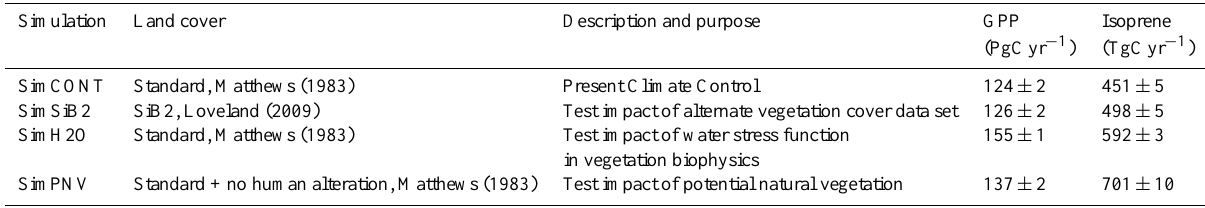
Table 2. Summary of global annual average carbon fluxes in the model runs. In total 10 model run years are included in the annual average for each simulation. All runs use 1996–2005 average monthly varying SSTs and sea ice. Uncertainty values are based on the standard error relative to internal climate model variability ( n =10yr).